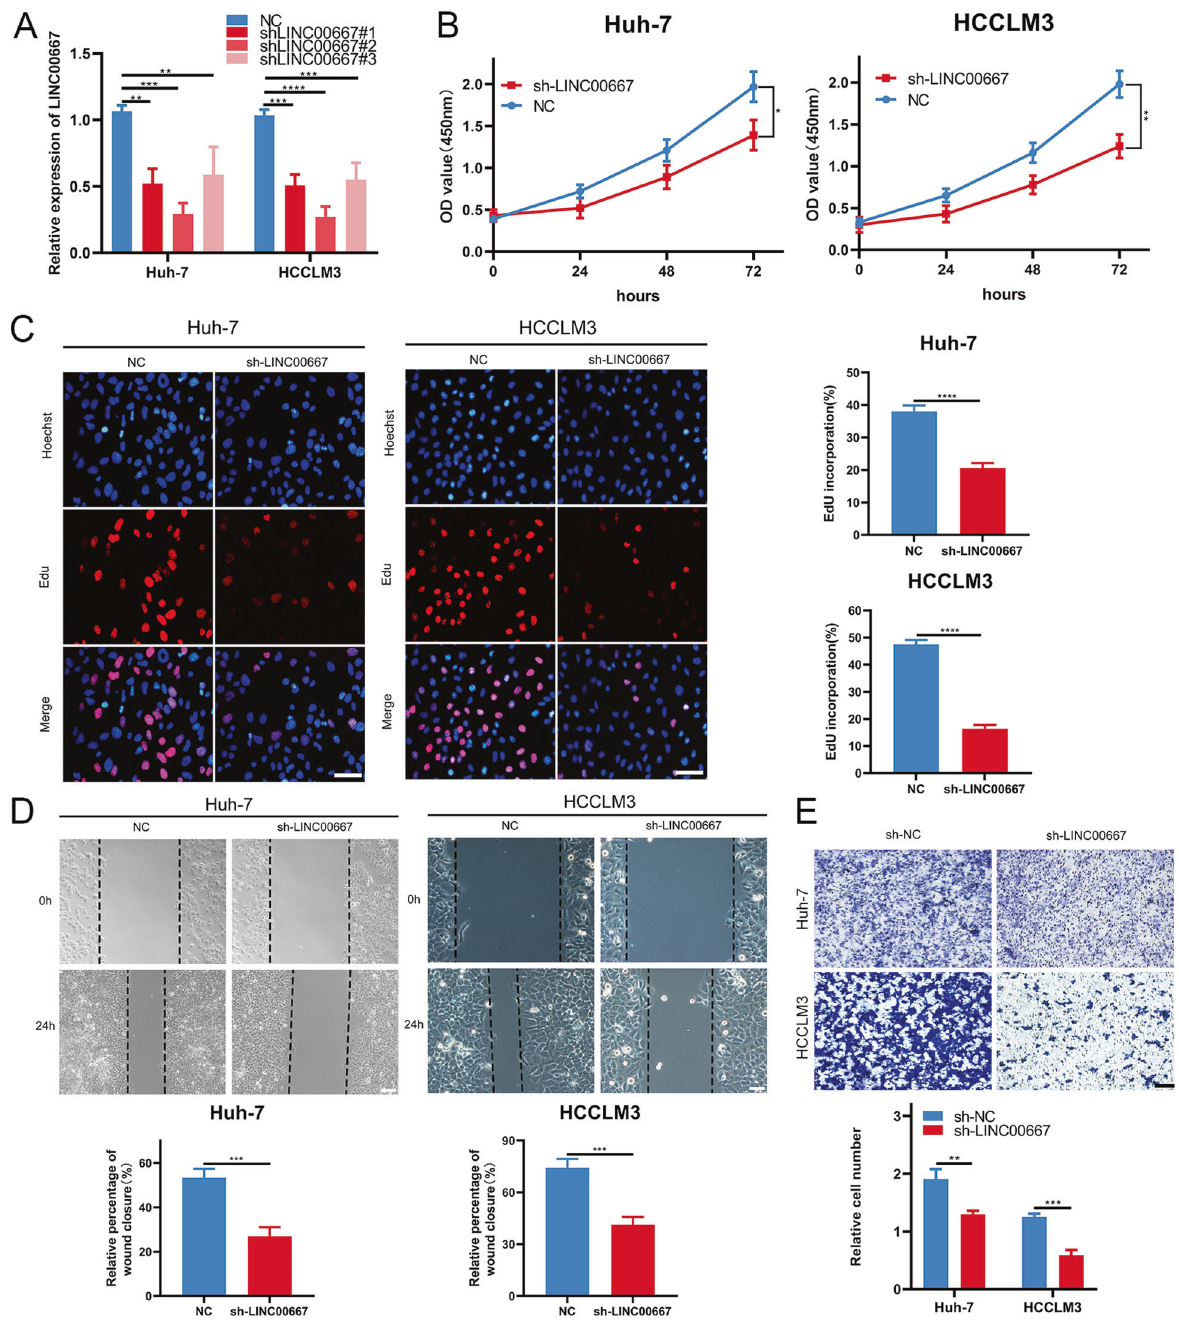
Fig. 2 LINC00667 aggravates CP, CM and CI in HCC cells. A Relative expression of LINC00667 was silenced by 3 shRNAs in HCCLM3/Huh-7 cells. Data ( n = 3) were analyzed by student ’ s t test. B and C Proliferative abilities of sh-LINC00667 or sh-NC-transfected HCCLM3/Huh-7 cells were evaluated by CCK-8 and EdU assays, respectively. Scale bar, 100 μ m. The result was analyzed by student ’ s t test. D Migratory capabilities of sh-LINC00667 or sh-NC-transfected HCCLM3/Huh-7 cells were determined by wound healing assays. Scale bar, 100 μ m. Data were analyzed by student ’ s t test. E Invasive capabilities of sh-LINC00667 or sh-NC-transfected HCCLM3/Huh-7 cells were determined by transwell assays. Scale bar, 150 μ m. Data were analyzed by student ’ s t test. Data, mean ± S.D. *, **, *** and **** = P < 0.05, < 0.01, < 0.001 and < 0.0001,